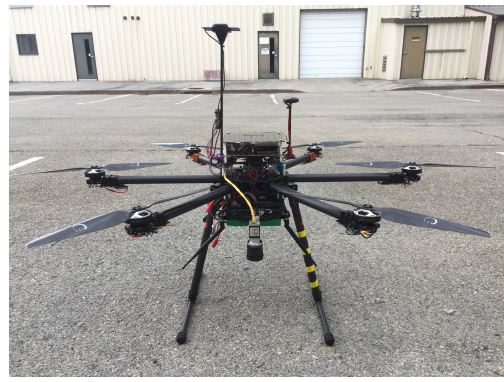
Figure 2. A custom unmanned aerial vehicle shown with the first-generation Swifnav Piksi RTK GPS unit.